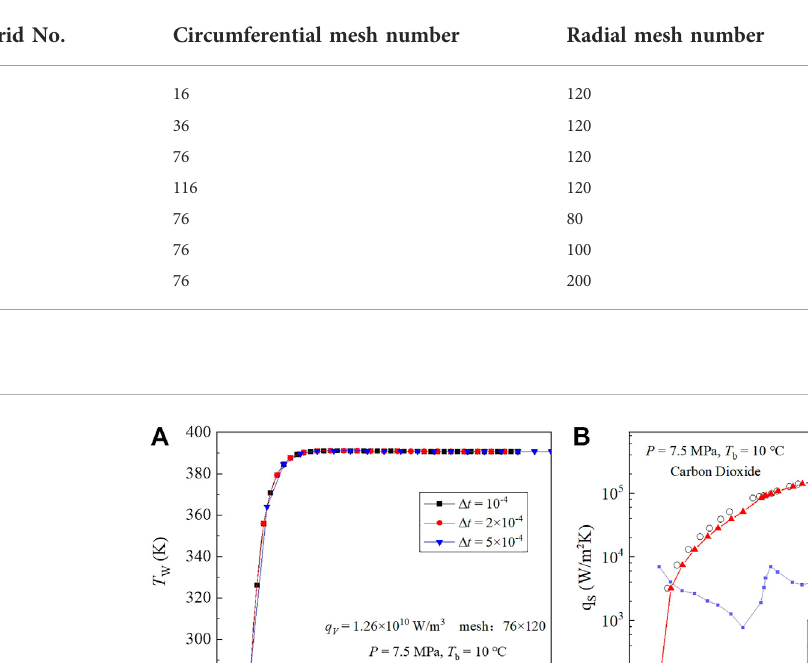
TABLE 3 Mesh independence